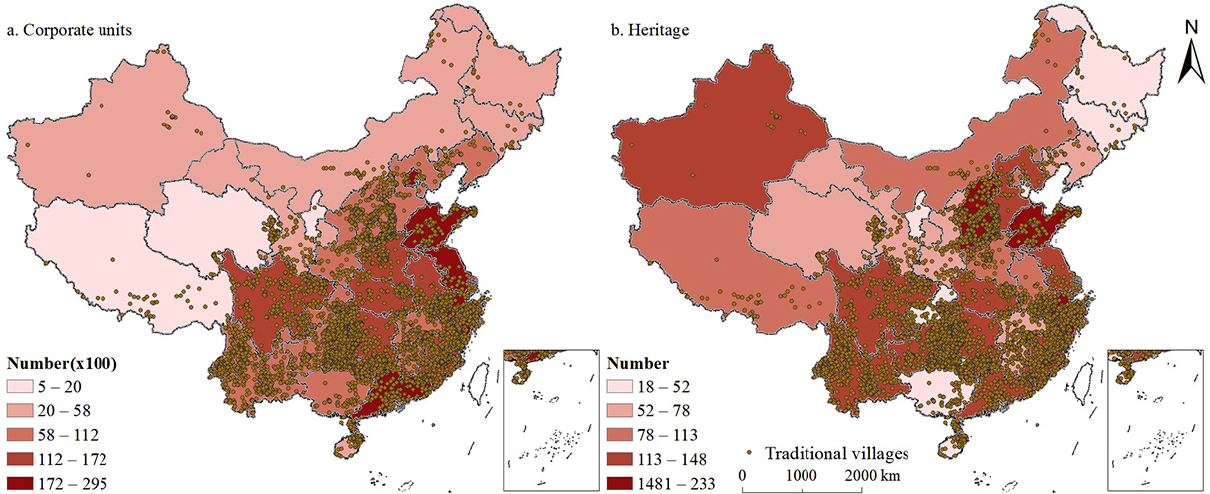
Figure 8. Spatial relationships between the distribution of traditional villages and humanities history of China.